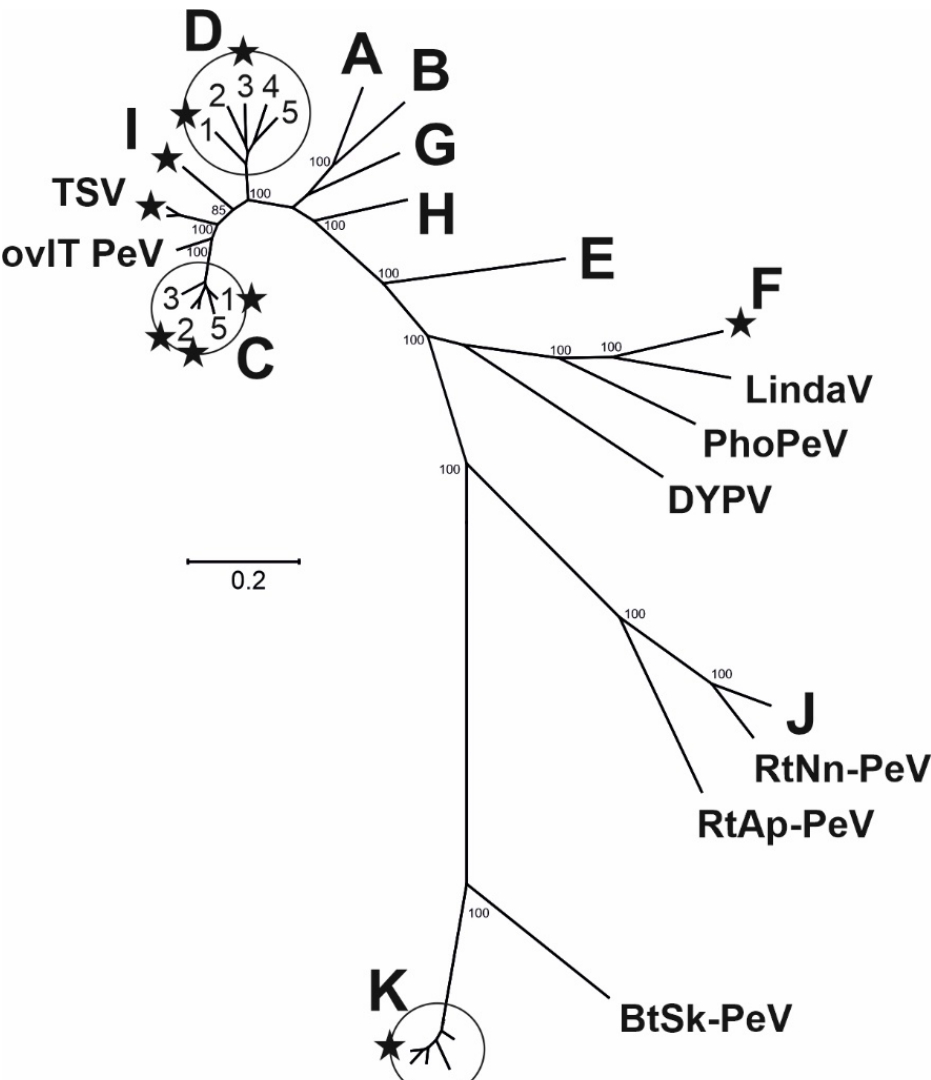
Figure 1. Genetic relatedness of pestiviruses. Phylogenetic analysis based on 32 polyprotein se- quences of approved pestivirus species and recently described unassigned pestiviruses having a length ranging between 3604 amino acids ( Pestivirus K , GenBank AUL76968) and 4026 amino acids ( Pestivirus J , GenBank YP009109567). Analysis was performed by Maximum Likelihood method using the Mega X software. For statistical analysis, the tree was calculated with 100 repetitions. Bootstrap values of ≥ 70 are indicated only for the main nodes that define pestivirus species. Established species ( Pestivirus A–K ) are indicated by letter code as proposed previously [1]. Unassigned pestivirus sequences are indicated by abbreviations of virus names (ovine Italy pestivirus, ovIT PeV; Tunisian sheep –like pestivirus, TSV; Linda virus, LindaV; Phocoena pestivirus, PhoPeV; Dongyang pangolin virus, DYPV; rodent Niviventer niviventer pestivirus, RtNn–PeV; rodent Apodemus peninsulae pestivirus, RtAp–PeV; bat Scotophilus kuhlii pestivirus, BtSk–PeV). Numbers in the circles refer to defined CSFV and BDV genotypes of the species Pestivirus C and Pestivirus D , respectively. Isolate names and GenBank accession numbers of used sequences are listed in the materials and methods section. Asterisks indicate the isolates used for cross-neutralization tests in this